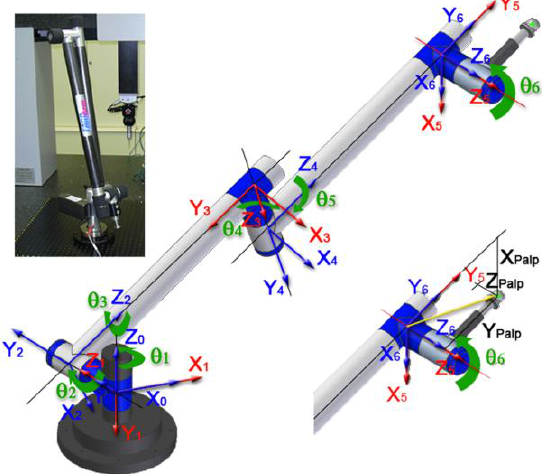
Figure 2. Model definition posture of FARO AACMM with D-H convention